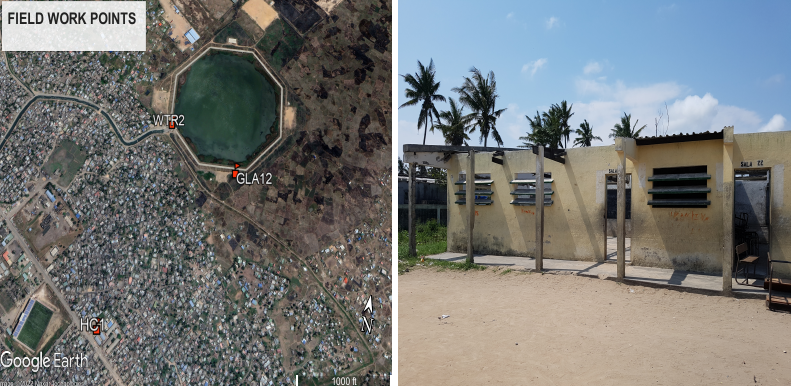
Figure 4. Red points on the left image are examples of GPS points that we collected during the field work in Beira. The label WTR2 stands for point 2 of water, GLA12 stands for point 12 of grass land, and CH1 stands for point 1 of houses in Chota Neighborhood. The right image corresponds to the point HC1 and illustrates some damaged classrooms of a public school in this